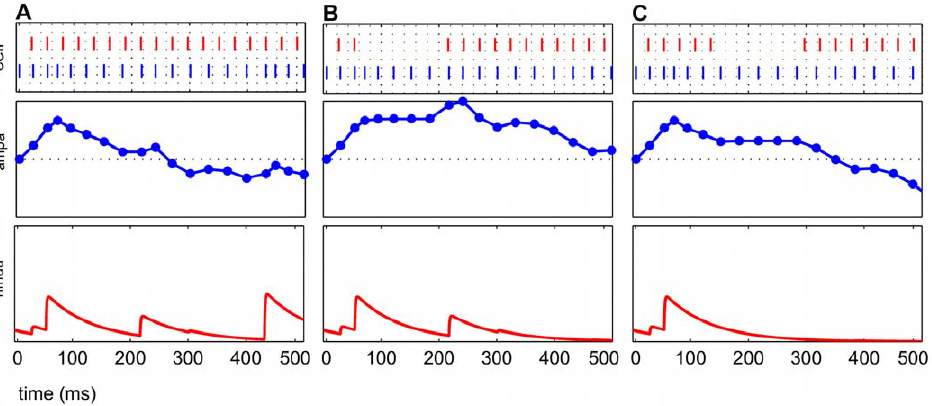
Figure 8. Inserting a pause in the input spiking prolonged potentiation. The pauses here are 125 ms long. The top panel in each subfigure shows a raster plot with input spikes (red) and cortical spikes (blue). Middle panels are the AMPAR conductance G ampa . Bottom panels are open probabilities for NMDAR currents n nmda . In each subfigure, the frequency regimes are the same ( f N ~ 31 Hz, f I ~ 37 Hz). (A) The AMPAR conductance rises, signifying potentiation in the first 250 ms. (B) Inserting a pause of 125 ms in the input spiking (seen in the raster plot) suspended plasticity. The pause of this length begins during the height of potentiation (at approximately 75 ms), and potentiation resumed with the input. The long time course of the NMDAR current allowed the cortical spike rate to change gradually enough to keep the cortical network in a potentiating regime. (C) This pause is started at 150 ms and is the same length as (B). The pause ends beyond the natural decay of the NMDAR current, and post-pause potentiation did not occur, since the E cell spikes were no longer being sustained at a potentiating rate.